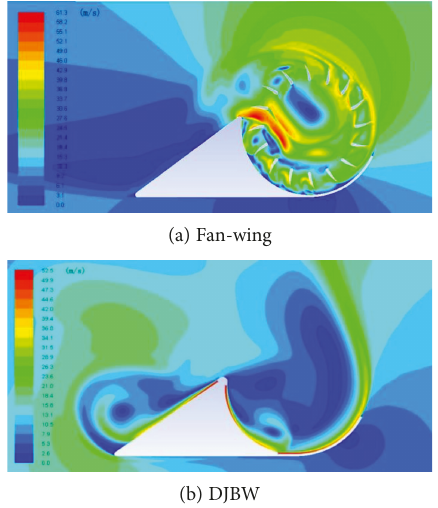
Figure 16: Velocity contour of two